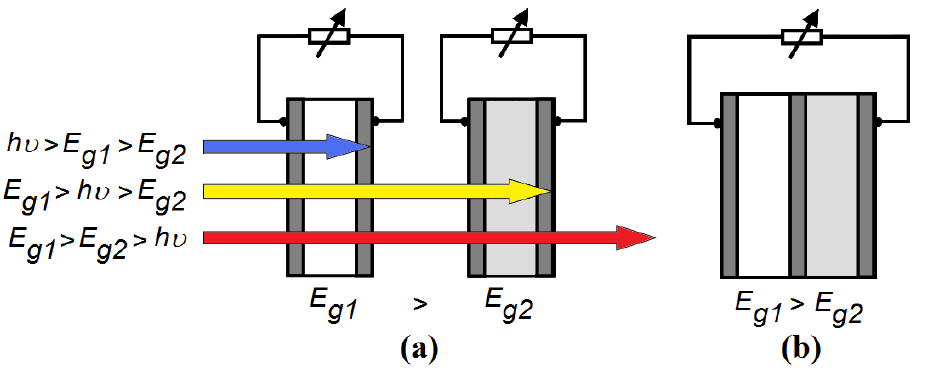
Figure 1. ( a ) A stacked or 4-terminal tandem solar cell: the first single cell absorbs . The second cell absorbs photons with an energy photons with an energy h  higher than E g1 between E and E . Photons with an energy below E are not absorbed. The two subcells g1 g2 g2 are electrically separated; ( b ) A monolithic or 2-terminal tandem solar cell: the single cells are electrically connected in